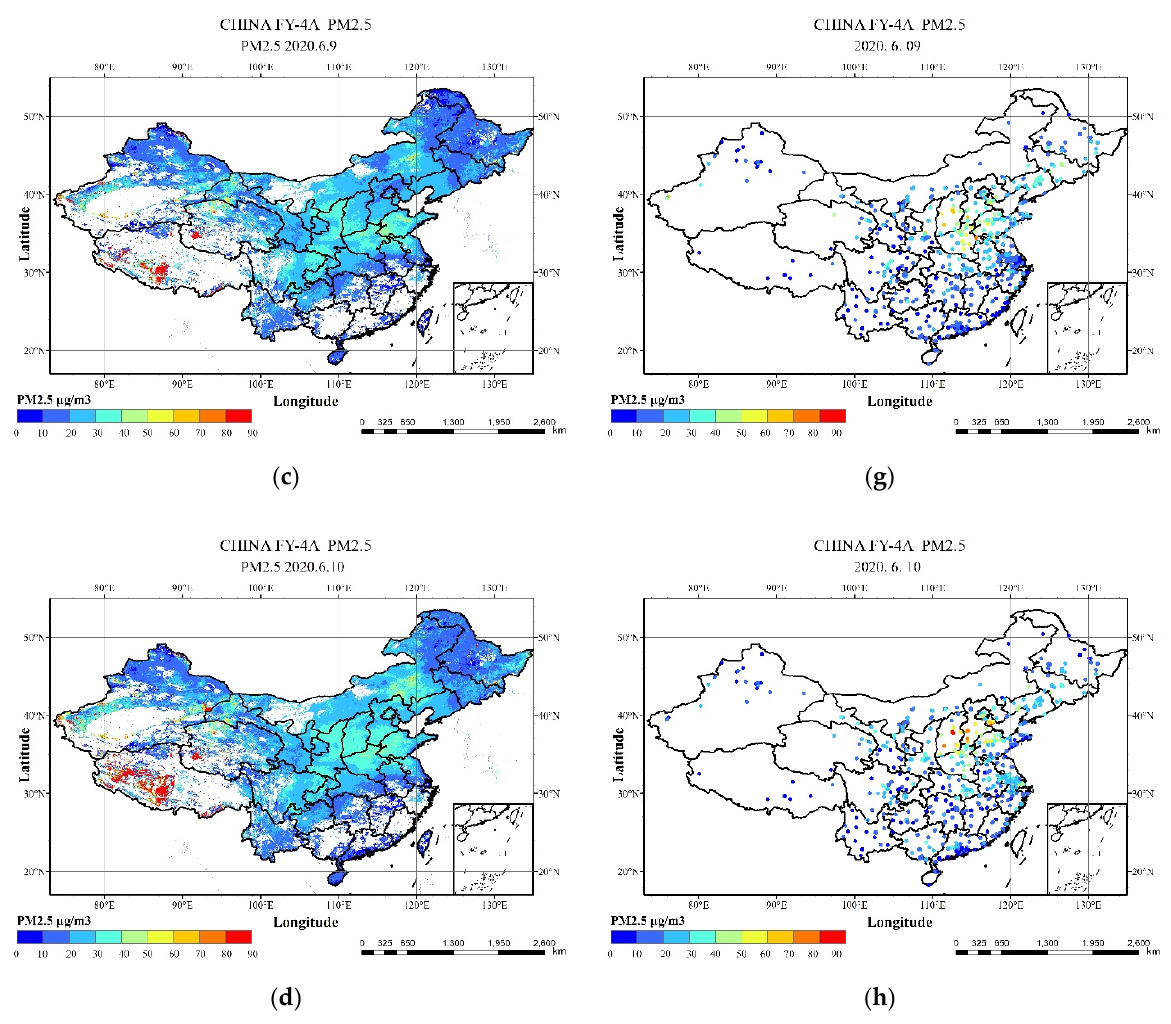
Figure 7. Average daily PM 2 . 5 concentration on 5–6 and 9–10 June 2020. Column 1 from ( a ) to ( d ) is model estimates and column 2 from ( e ) to ( h ) is station observations (columns 1 and 2, from left to right).